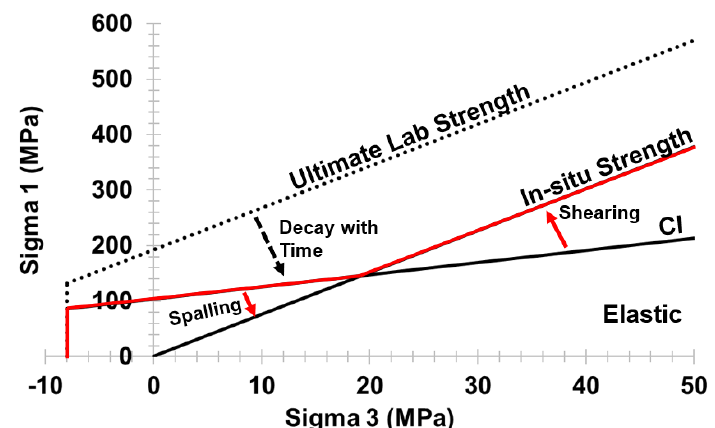
Figure 1. Strength envelope of the LdB granite at the AECL URL (CWFS) used to describe in − situ strength and development of brittle failure. Modified from [8,25]. Table 1. Constitutive model selection based on rock strength and GSI, modified from [8]. Note that UCS and T indicate intact unconfined compressive strength and tensile strength, respectively.